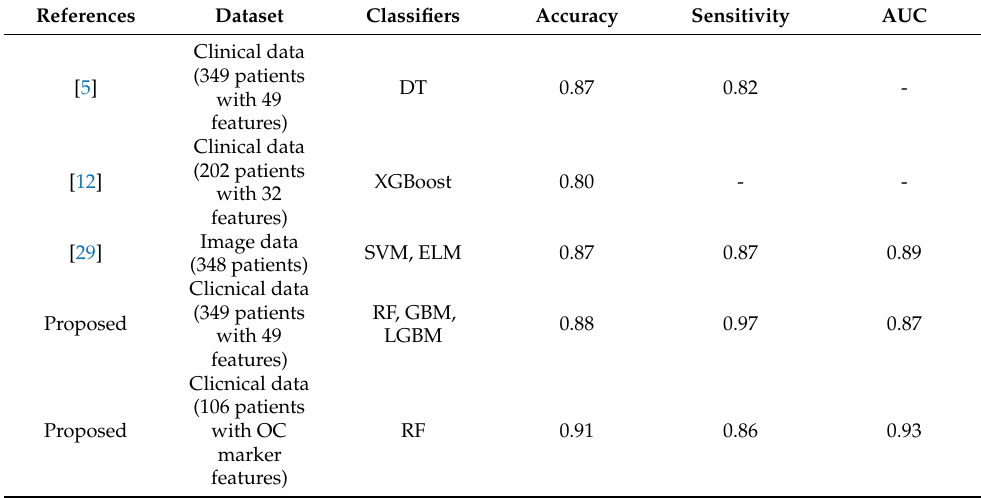
Table 5. A comparison between proposed methods and previous